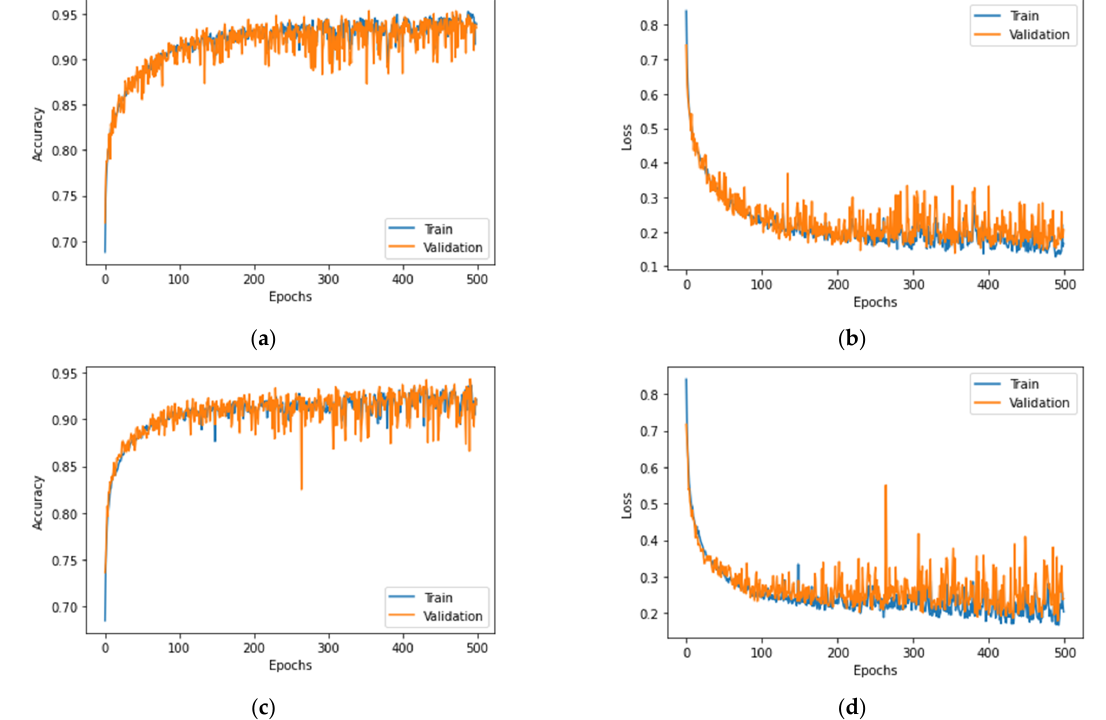
Figure 10. Accuracy and loss plots for training and validation: ( a ) accuracy plot for the network with 51 input features; ( b ) training and validation loss for the network with 51 input features; ( c ) accuracy plot for the network with 27 input features; ( d ) training and validation loss for the network with 27 input features.